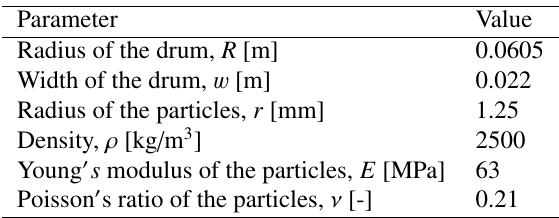
Table 1. Properties of the drum and the